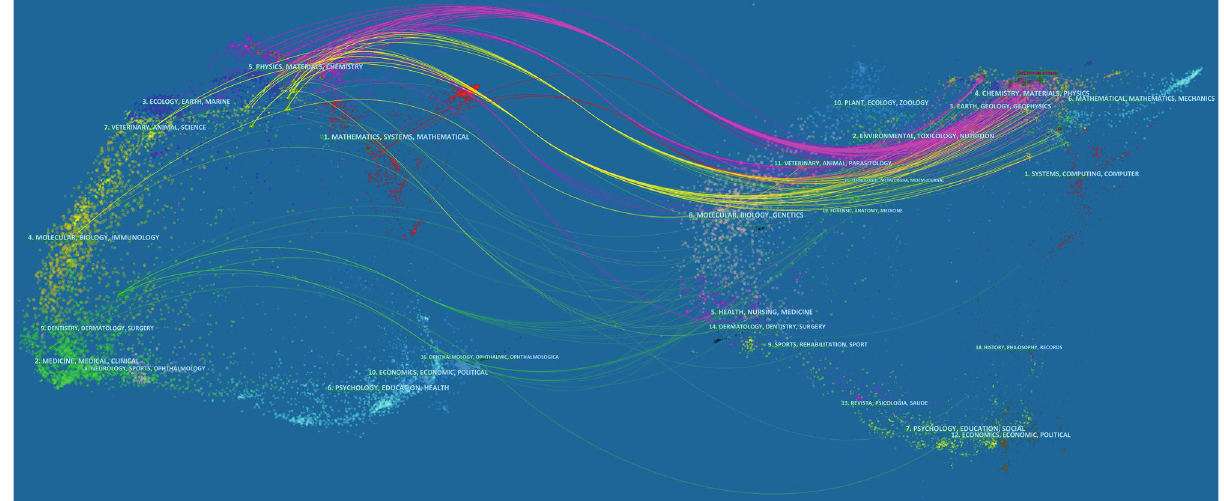
Figure 2: Dual-map of published papers and citations related to PET-based materials for separator